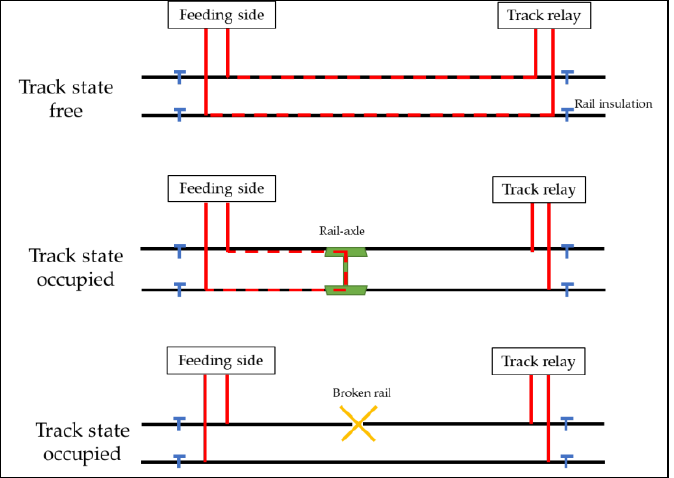
Figure 1 . Functional principle of track circuits. Source based on: [1] . Figure 1. Functional principle of track circuits. Source based on: